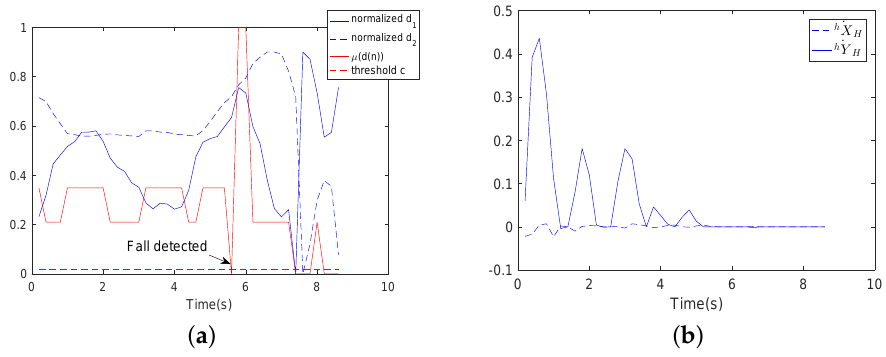
Figure 18. Wearable sensor-based user fall detection experiment using the walking-aid robot (falling to the left). ( a ) Feature d1(n) is the distance between the center of pressure (COP) and the midpoint of the user’s two feet. Feature d2(n) is the height of the user’s waist. µ ( d ( n )) is the membership degree value. The threshold value is 0.2. ( b ) The moving velocities of the robot.